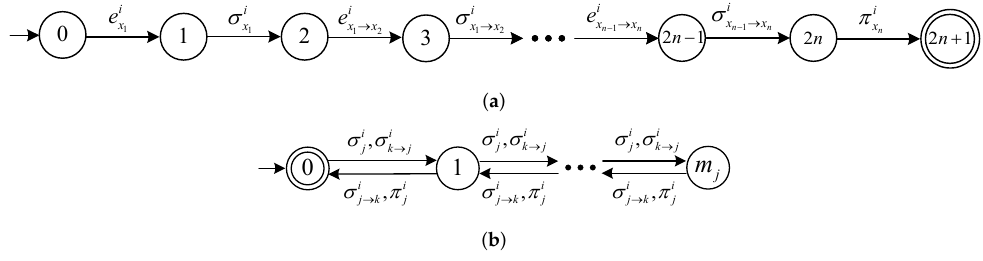
Figure 1. Automata P i and R j ; ( a ) Automaton P i for Process i ; ( b ) Automaton R j for Resource j